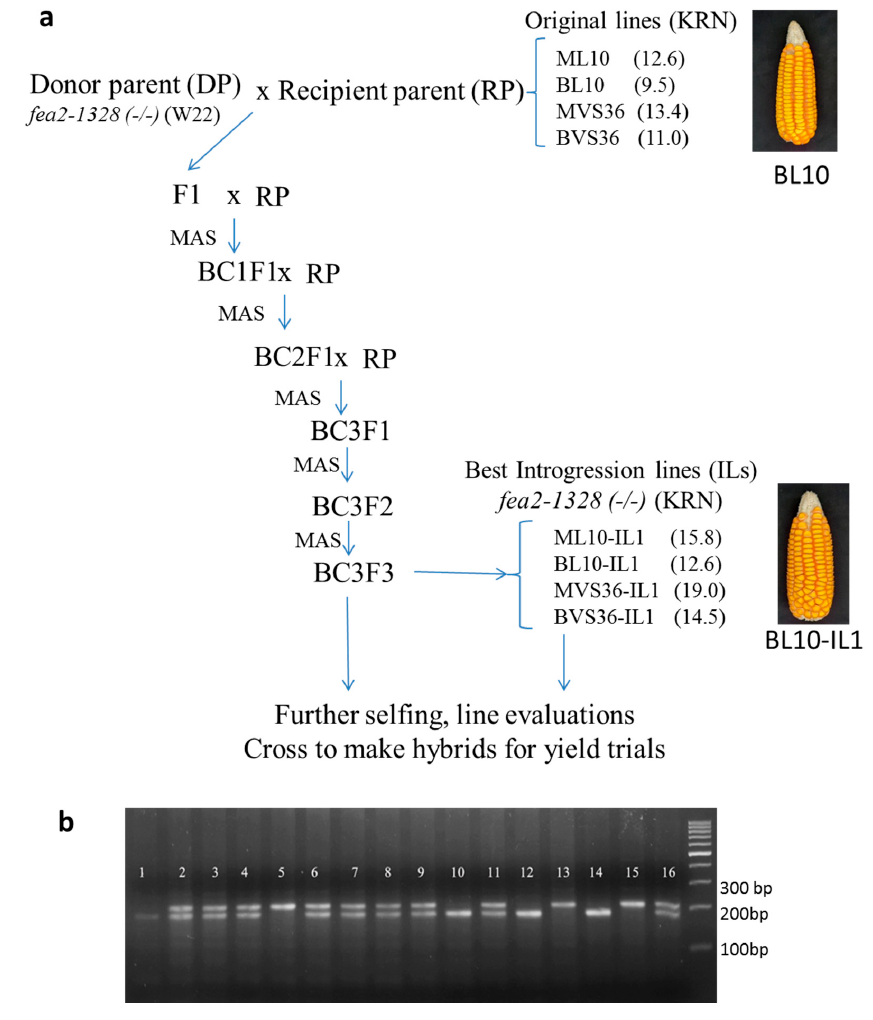
Figure 1. ( a ) The schematic diagram of developing introgression lines; the averages of kernel row number (KRN) were given in brackets for each line. ( b ) Genotyping the fea2-1328 alleles with a dCAPs marker. A F 2 family segregating for fea2-1328 was analyzed with the dCAPs marker using oSV1 and oSV2 primers. PCR products were cut with PstI and analyzed on 3% agarose gel. This marker clearly distinguished three types of genotypes: wild-type plants (lane number 1, 10, 12, and 14), homozygous mutant plants (lane number 5, 13, and 15), and heterozygous plants (lane number 2, 3, 4, 6, 7, 8, 9, 11, and 16).